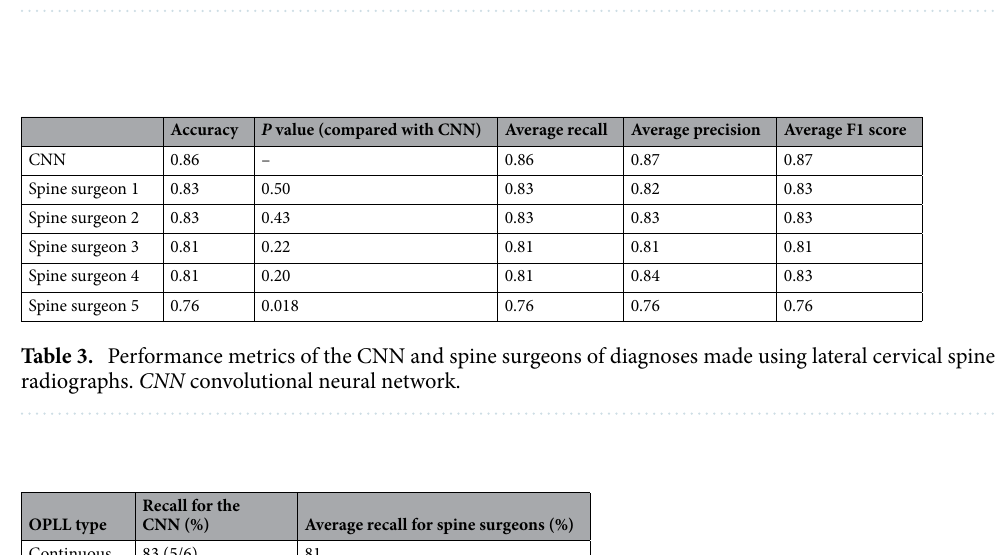
Table 2. Confusion matrix of the CNN model. CNN convolutional neural network, OPLL ossification of posterior longitudinal ligament.